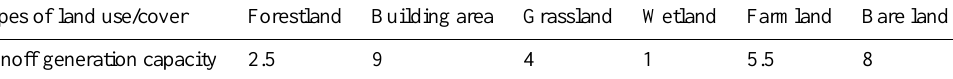
Table 4. The relative generation index of runoff from land cover. Fig.4. The relationship between the Dongting Lake area and Changjiang rivers Fig.4. The relationship between the Dongting Lake area and Changjiang rivers